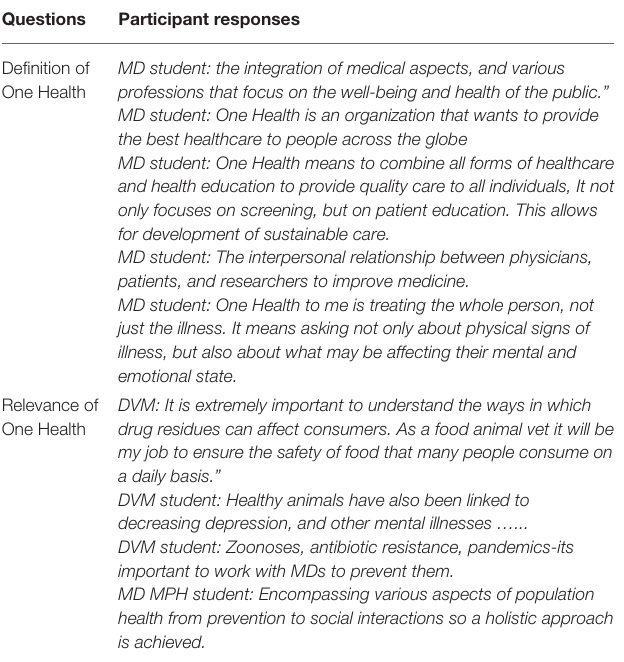
TABLE 4 | Incorporation of environmental health and the expanded area of